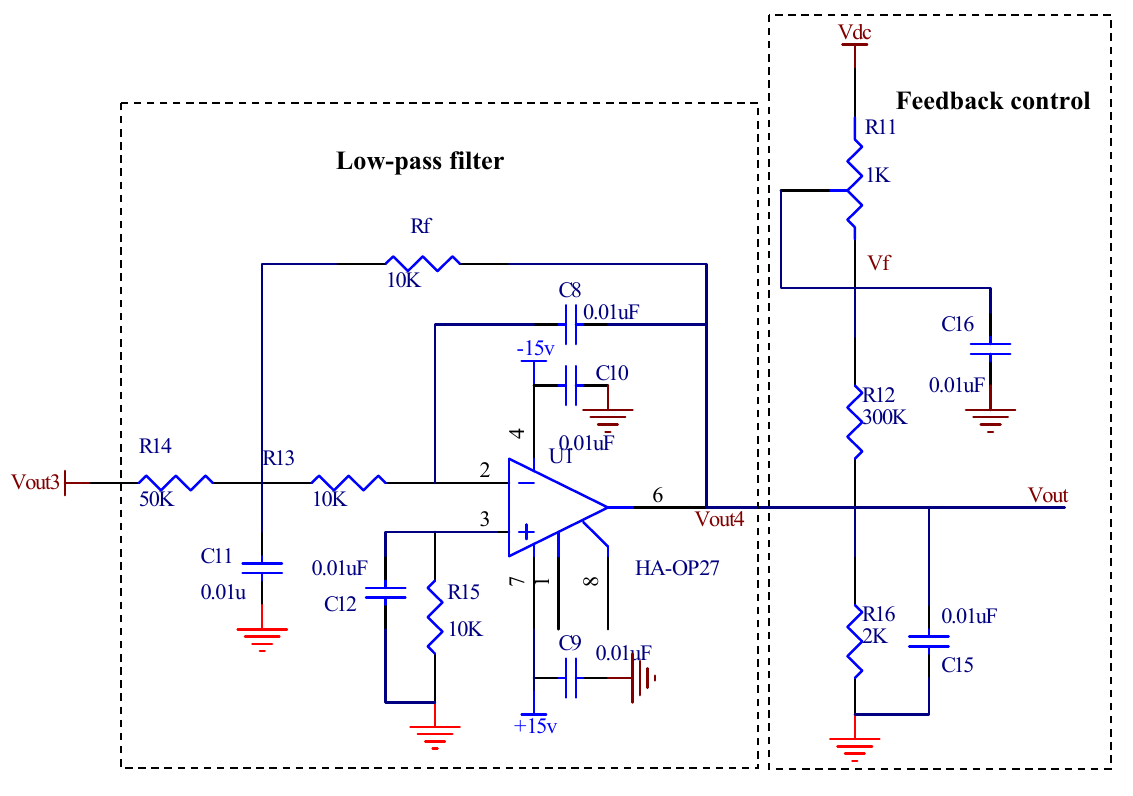
Figure 10. The circuit of low-pass filter and feedback control